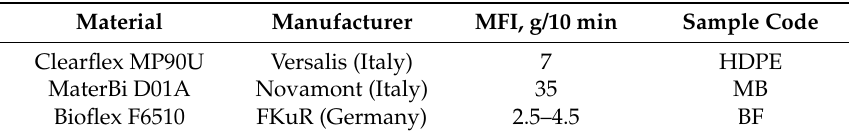
Table 1. Materials used in this work and related codes.